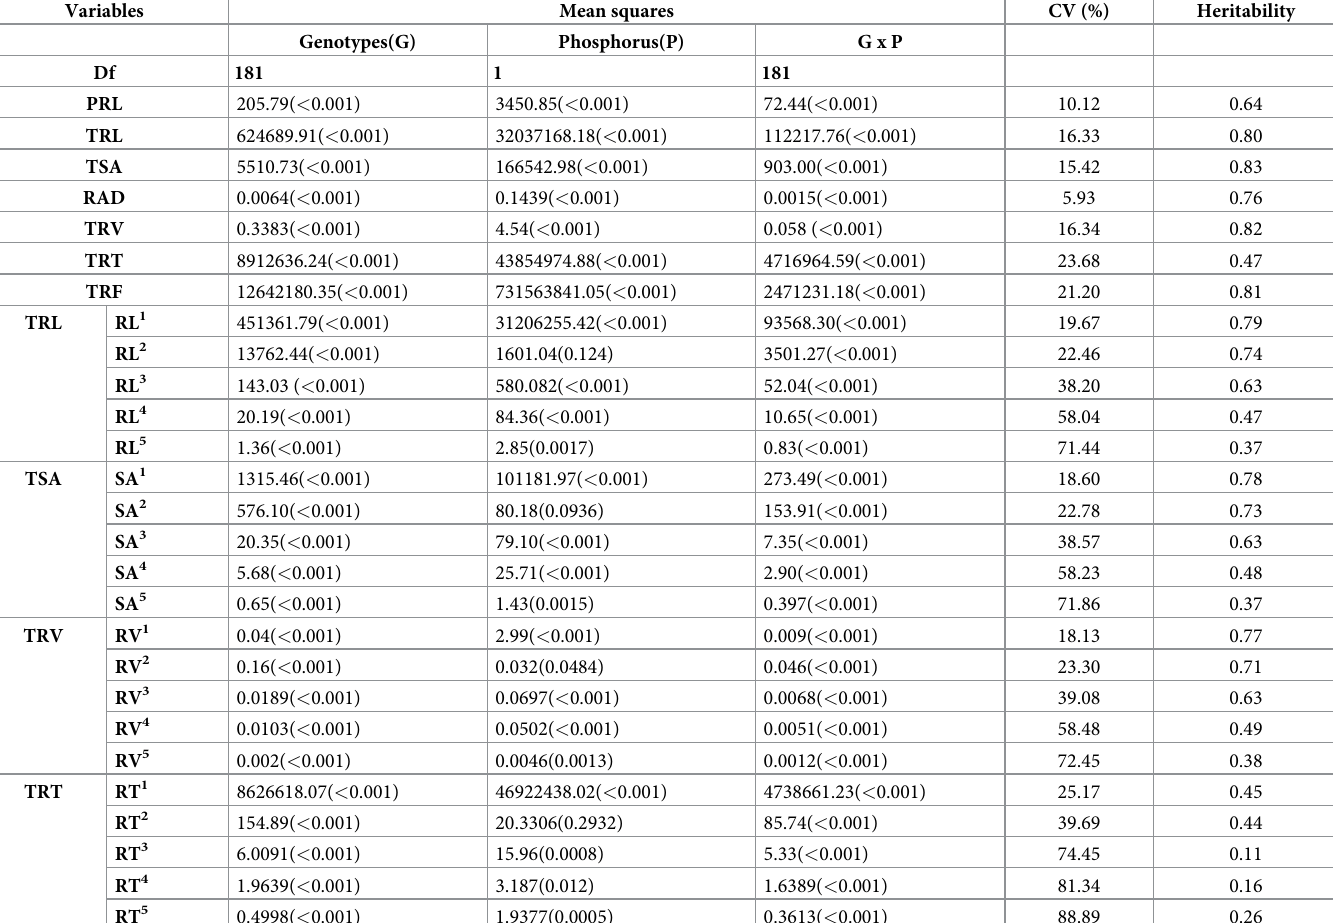
Table 1. Variance components, expected mean squares and heritability for root traits among 182 genotypes evaluated under non-limiting and limiting phosphorus conditions.